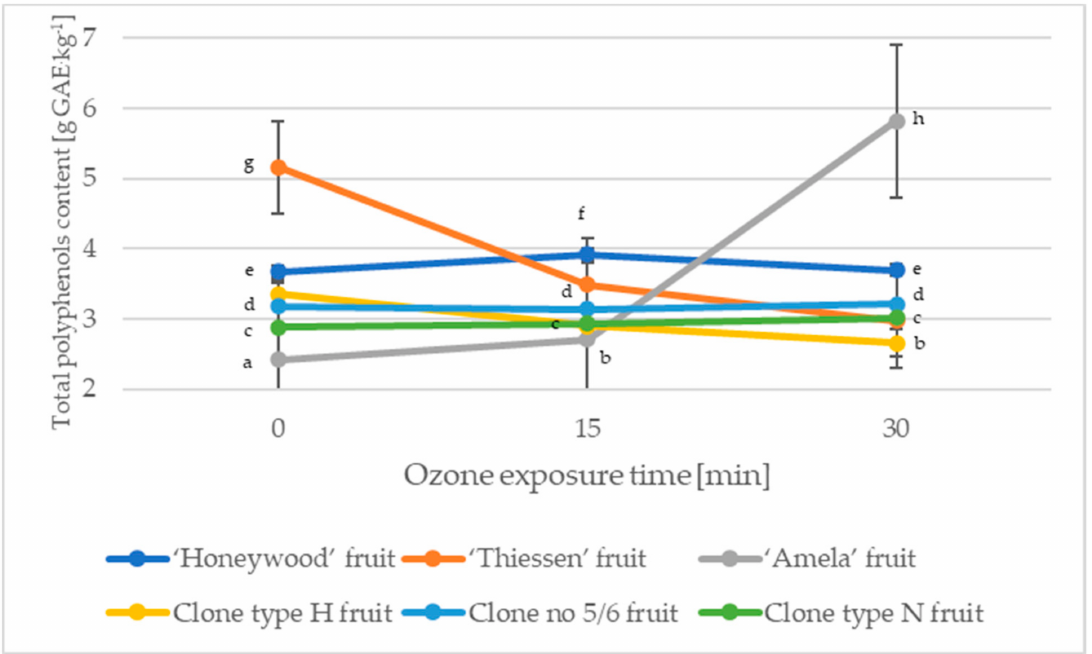
Figure 4. Changes in the total polyphenolic content of Saskatoon berry fruit during ozone. Data are expressed as mean values (n = 3) ± SD; SD—standard deviation. Mean values with different letters are significantly different ( p <